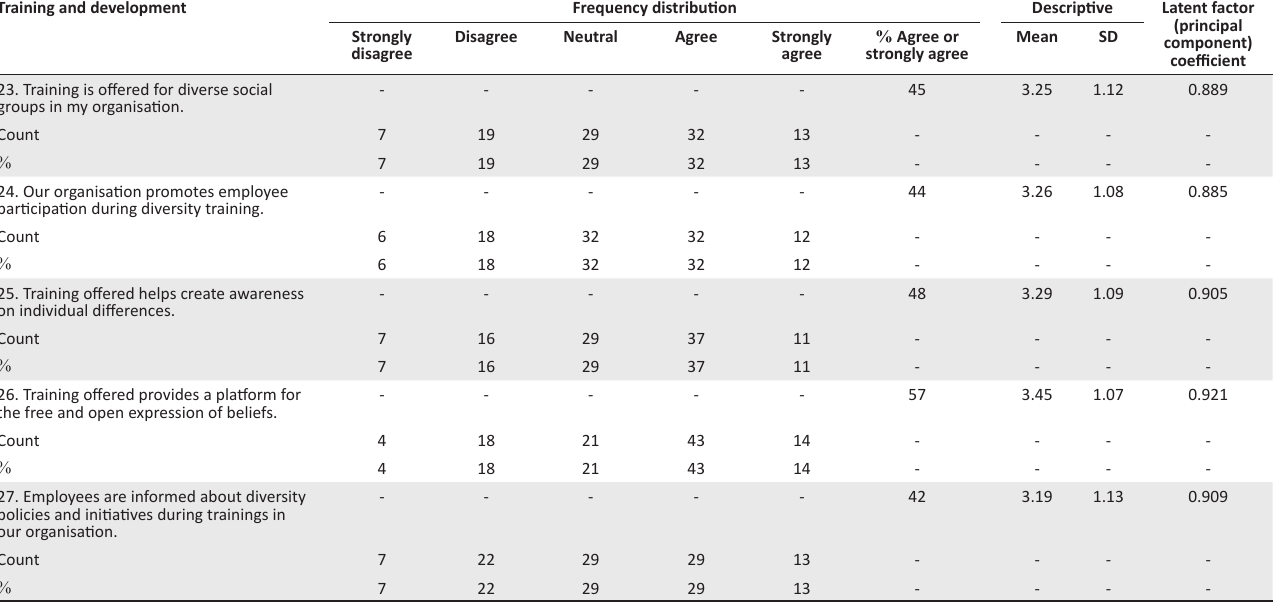
TABLE 8: Analysis of the construct of training and development.